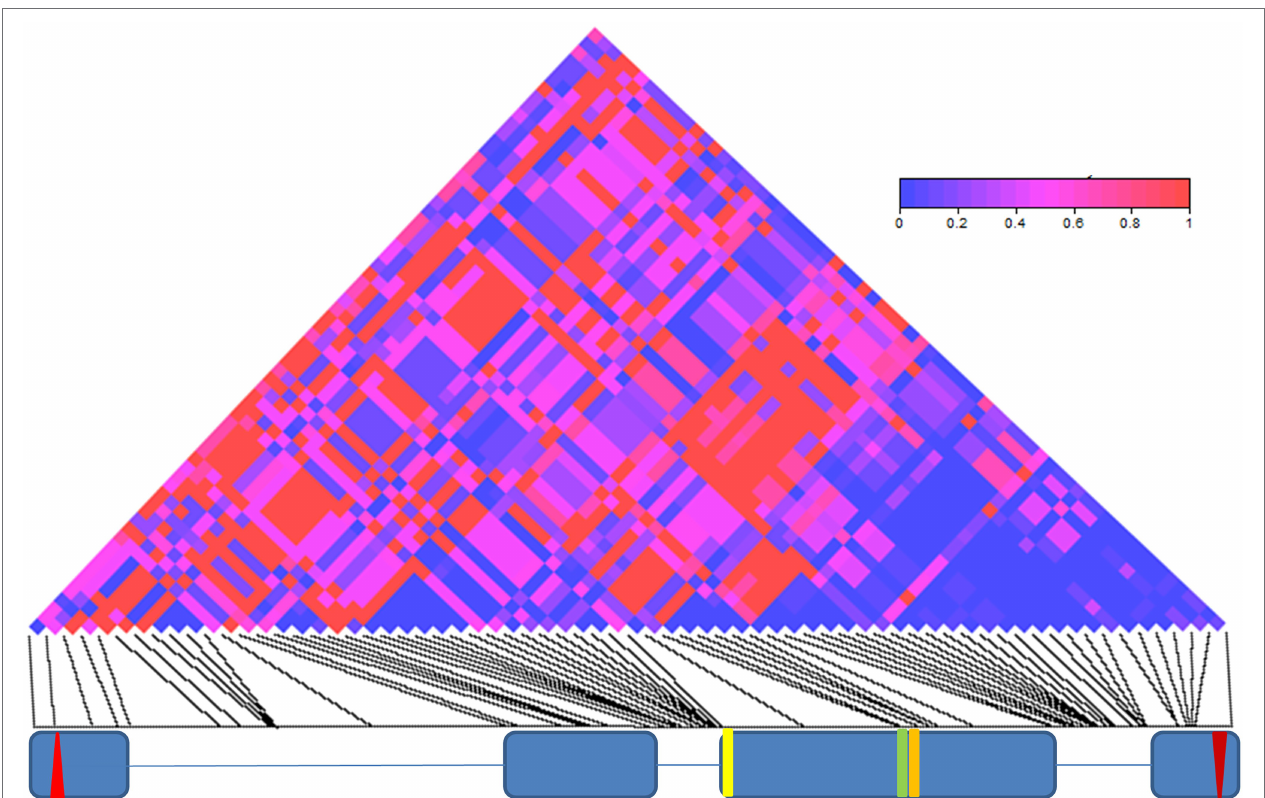
FIGURE 2 | Linkage disequilibrium (LD) in cry . LD across the 3,848 bp-long cry genomic region is depicted as a matrix of pairwise comparisons among 69 informative sites. Values of p (Fisher’s exact test) are shaded according to level of significance (see color code). The exon (blue boxes) and intron (lines) structure of cry is depicted below. The red up- and down-oriented triangles indicate the start and stop codons, respectively. Yellow, green, and orange vertical lines indicate three non-synonymous substitutions (L232H, E335D, and D348N,